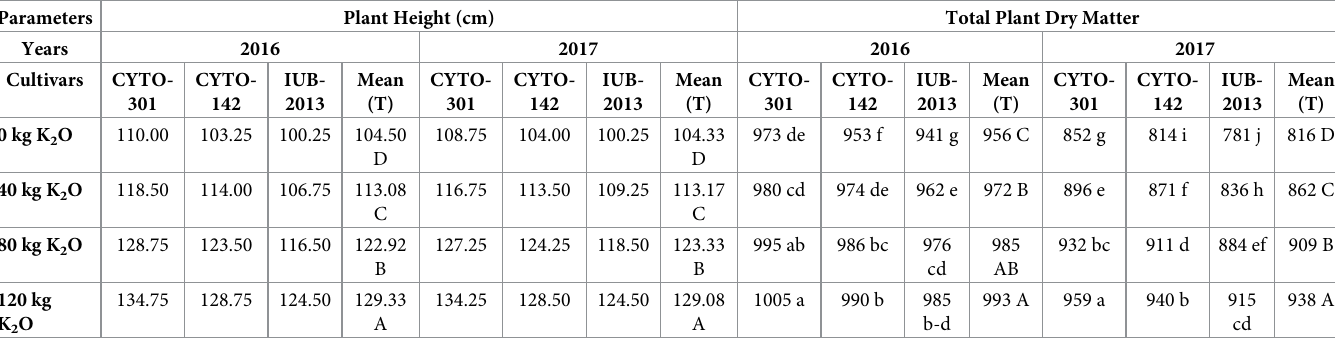
C = Cultivars, T = Treatments, NS = Non-significant, Different alphabets with in the same column or row indicate statistically significant differences.